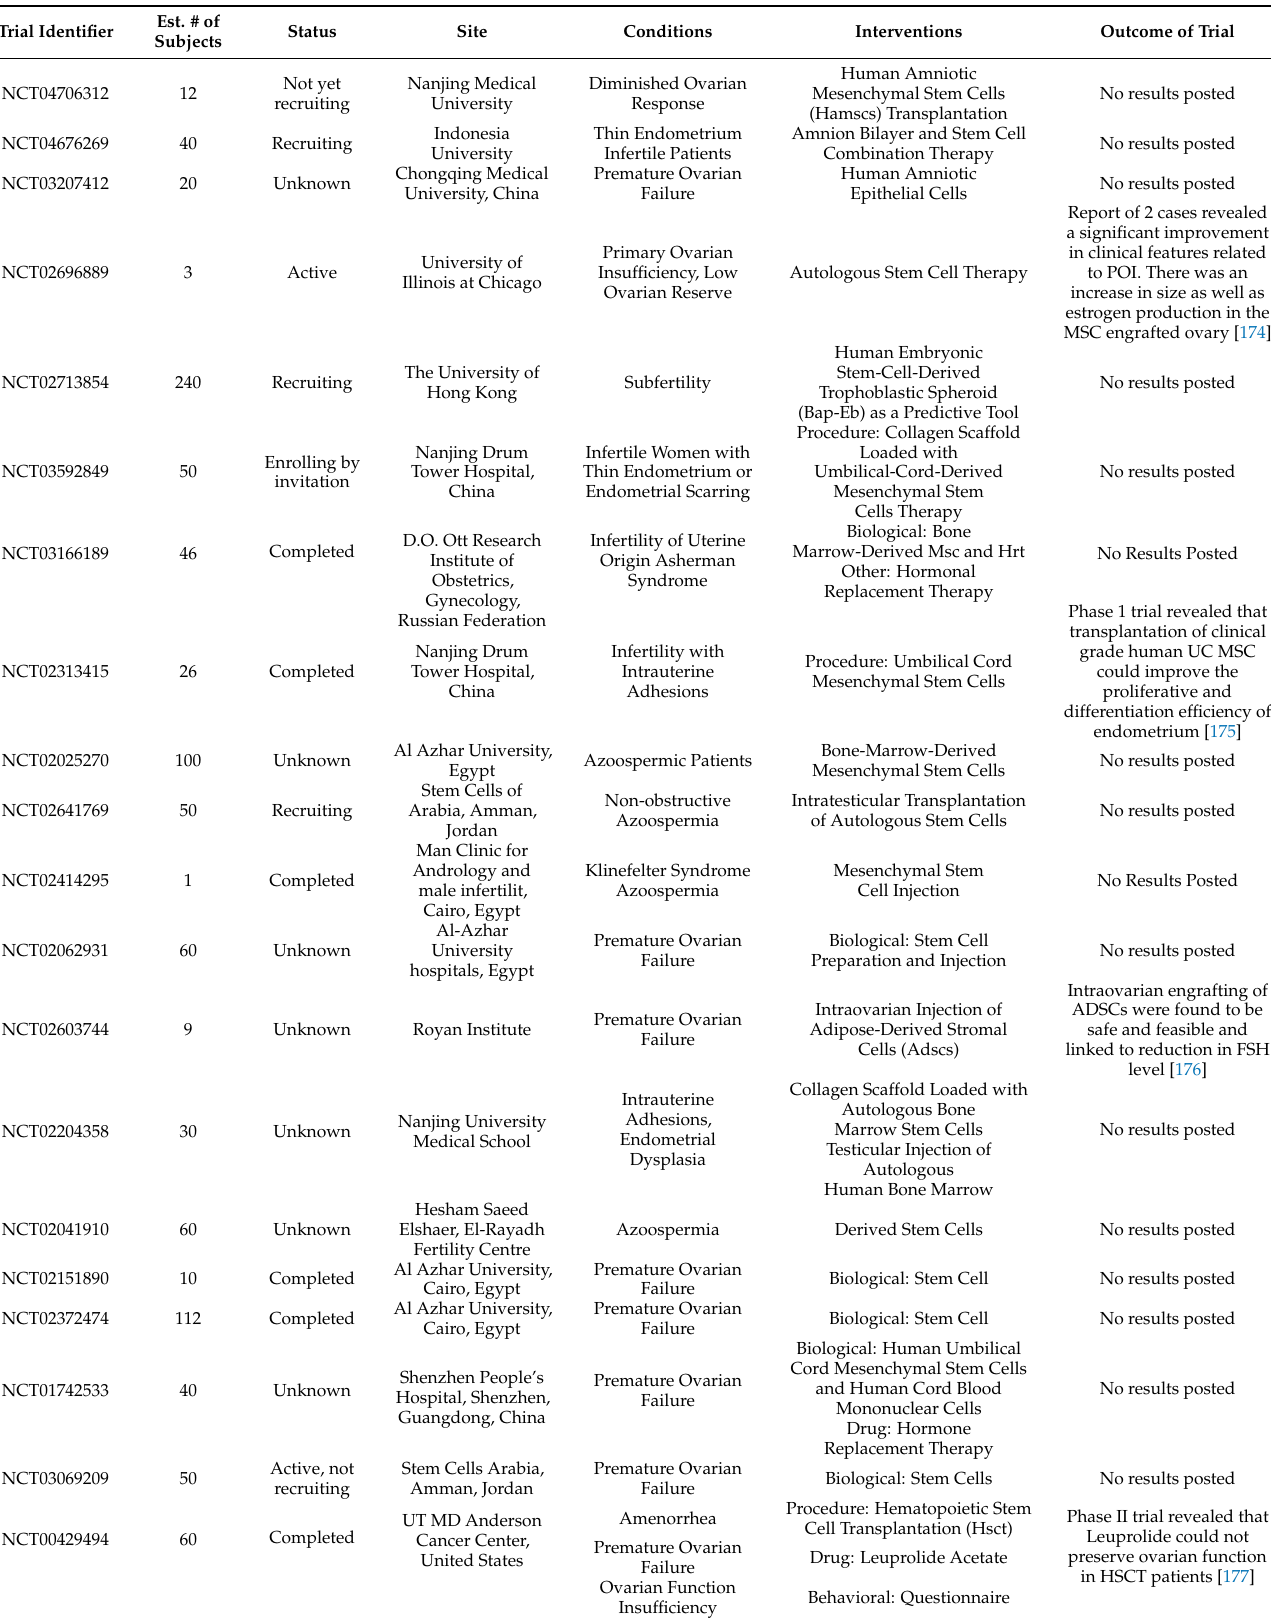
Table 1. Clinical trials related stem cell therapy performed or underway for improvement of infertility. Trial